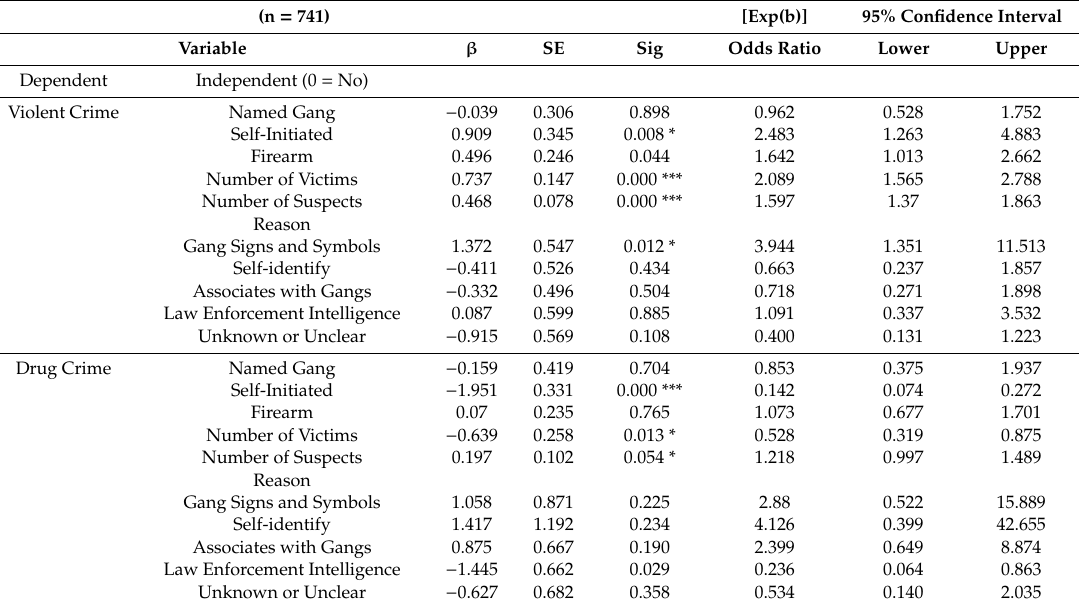
Table 3. Multinomial logistic regression for violent crime and drug crimes compared with other non-violent